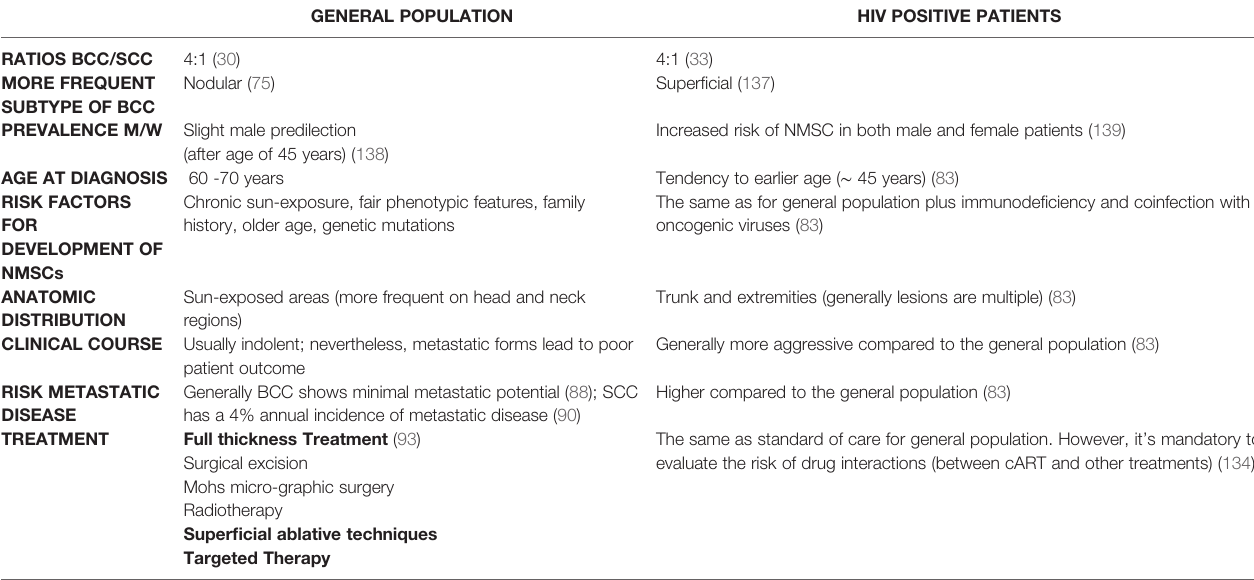
TABLE 4 | Synoptic picture with differences between PLWH and